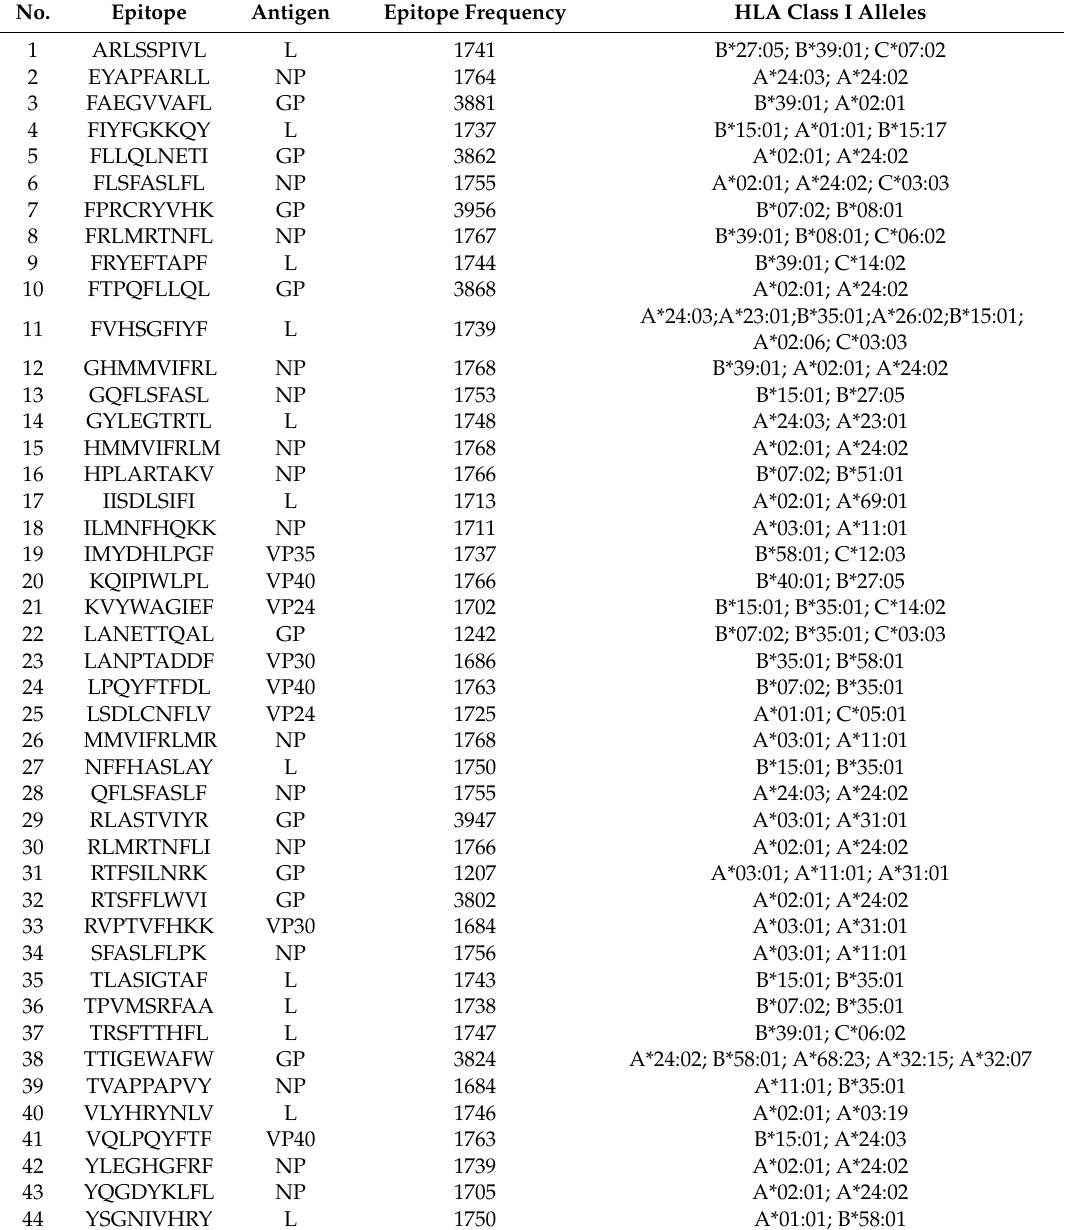
Table 1. Predicted CD8 + cytotoxic T-lymphocytes (CTL)-epitopes in the sequences of Ebola virus proteins